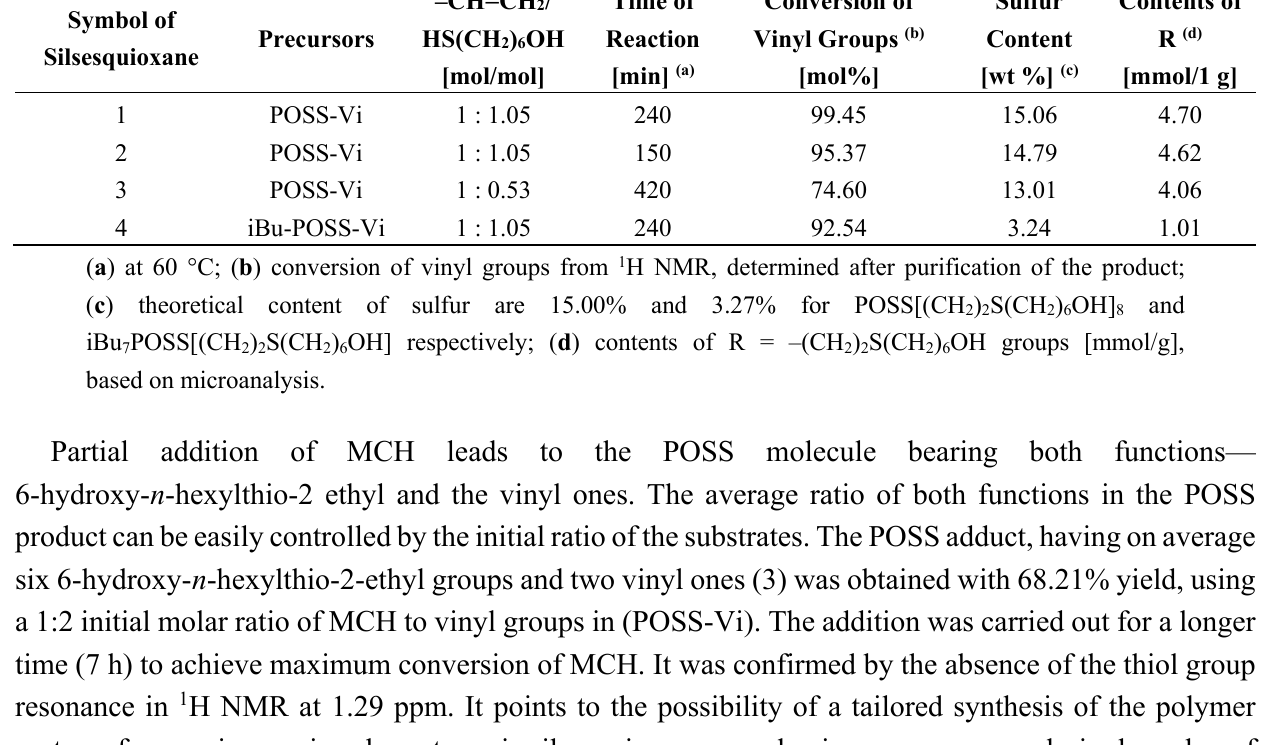
Table 1. Thiol-ene addition of 6-mercapto-1-hexanol to vinyl substituted cube-octameric silsesquioxanes. Symbol of Silsesquioxane